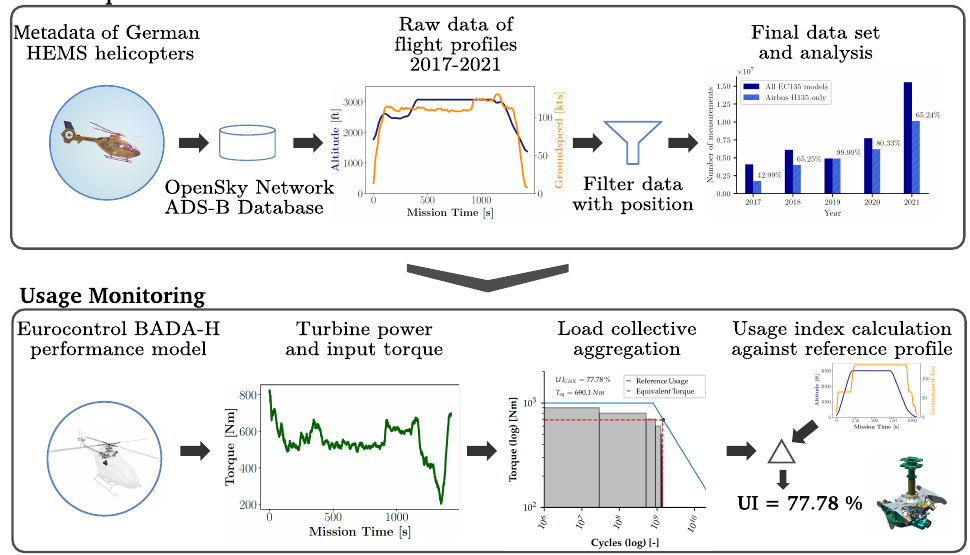
Figure 2. Overview of the acquisition of the ADS-B data set and the usage monitoring